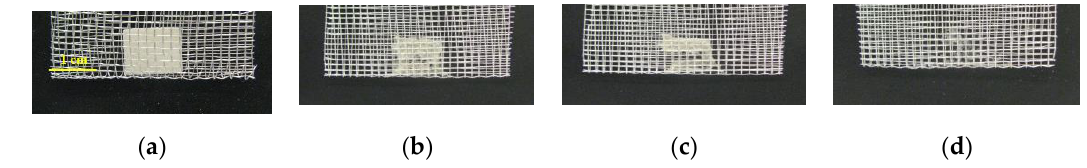
Figure 3. Sequential images of degradation of 0.5 A substrate. ( a ) 0 s; ( b ) 10 s; ( c ) 30 s; ( d ) 300 s.